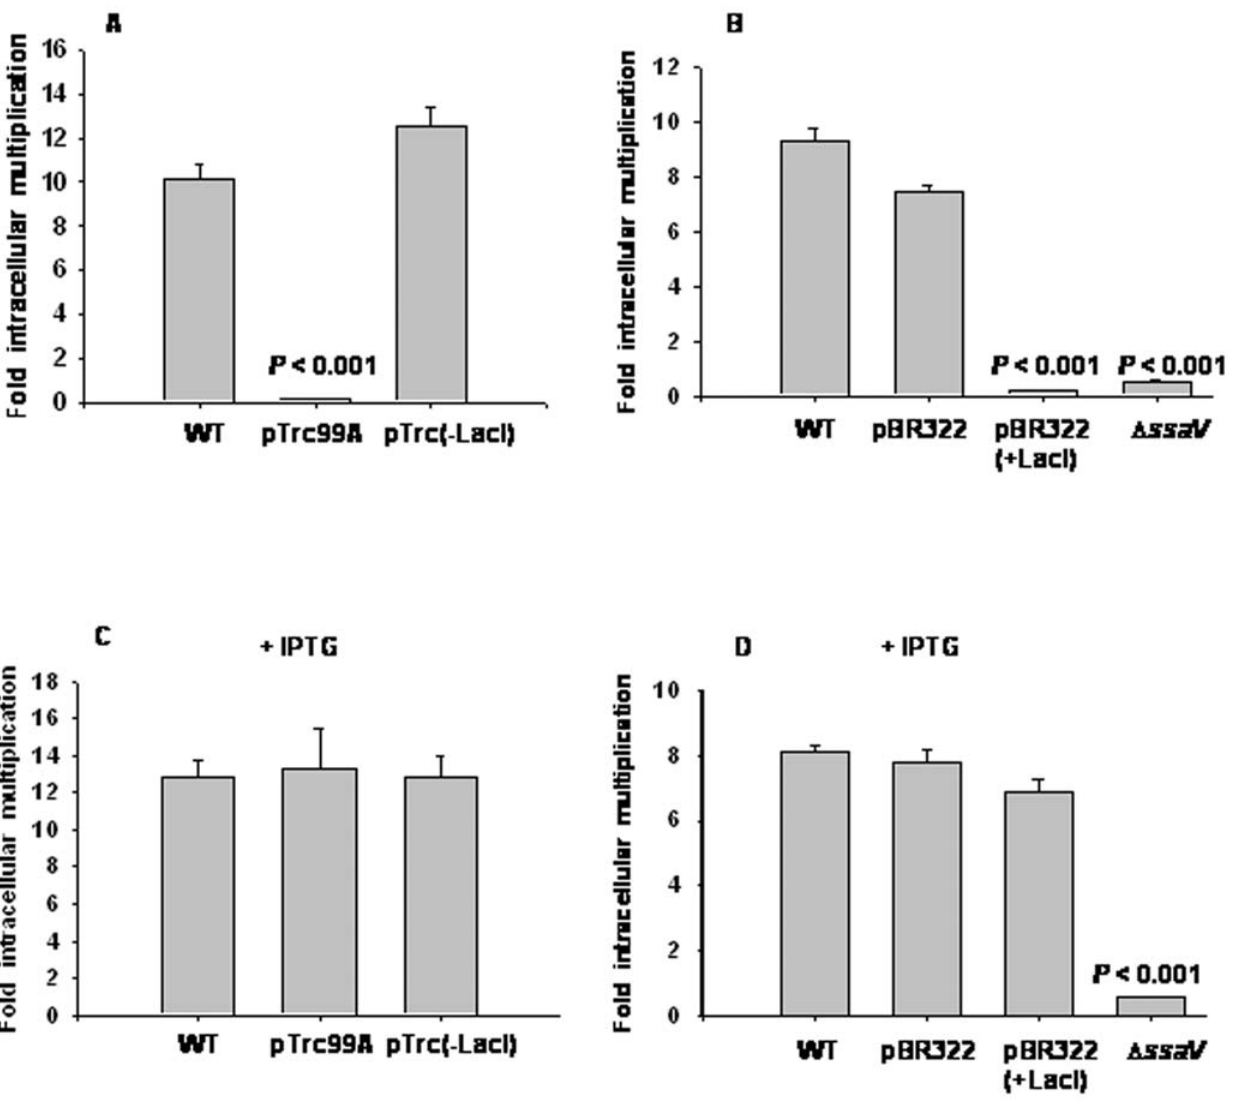
Figure 3. Expression of LacI in S . enterica suppresses its ability to proliferate inside murine macrophages. RAW-264.7 cells were infected with different strains as indicated at a MOI of 1:1 in the absence (A and B) or presence (C and D) of 10 mM IPTG. In all experiments, fold multiplication of S . enterica inside RAW 264.7 cells was calculated by dividing the intracellular bacterial load at 16 h by the intracellular bacterial load at 2 h. The bars represent mean fold-multiplication 6 standard error. Fold-multiplication of different strains were compared with that of the WT strain to calculate the P value using Student’s t-test. Graphs shown are representatives of at least two independent experiments done in triplicates in each case.